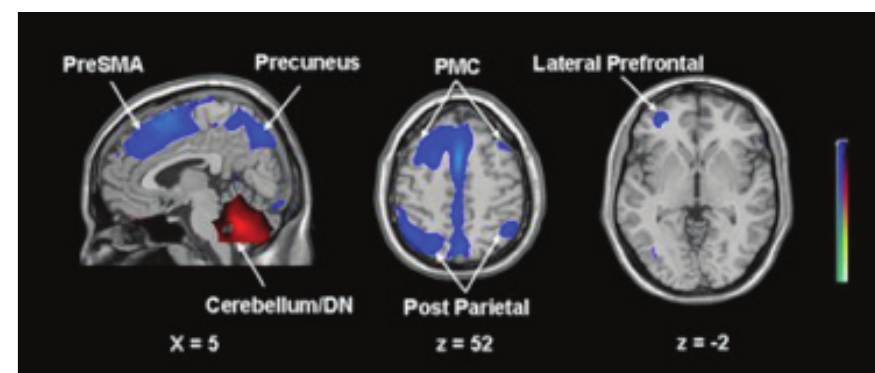
Figure 1: Image manifestation of a schizophrenic patient with recurrent